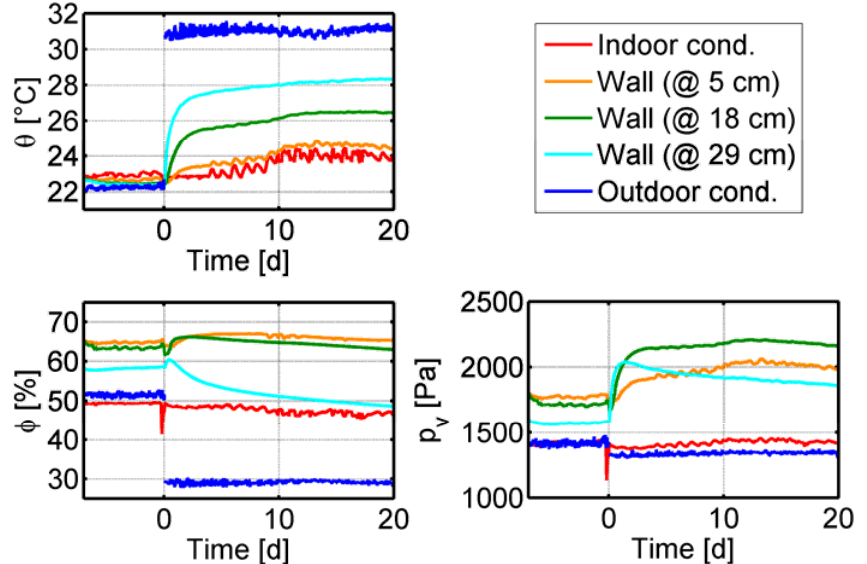
Figure 5. Time response in θ , ϕ and p wall subjected to temperature and relative humidity